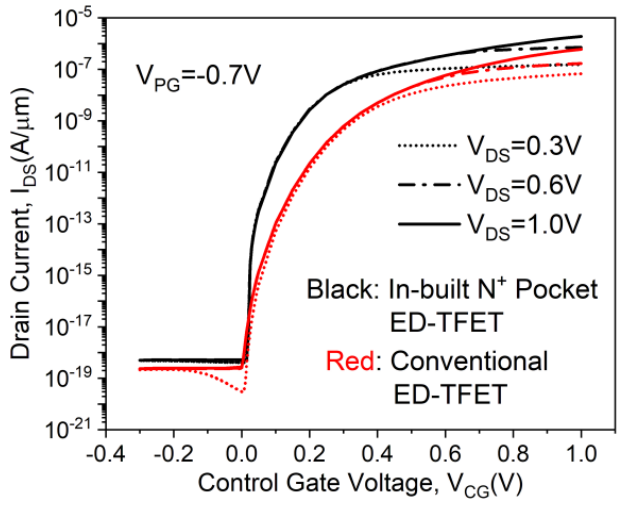
Figure 3. Transfer characteristics of conventional and in-built N + pocket ED-TFET for different V DS.